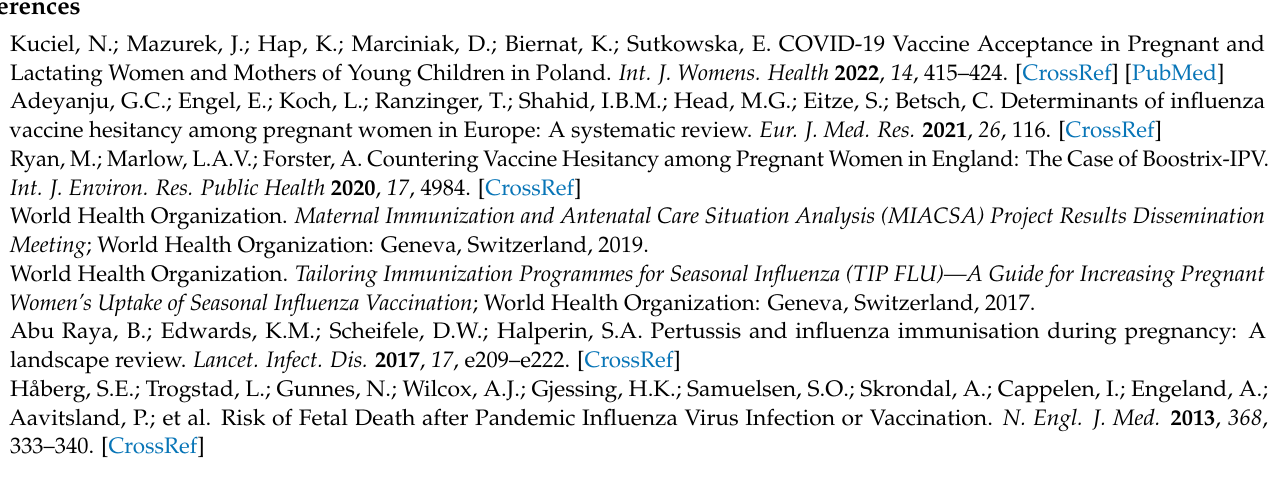
vaccination during pregnancy; Table S2. Factors for decision-making and women’s profiles; Table S3. Motivational factors for deciding to be vaccinated during pregnancy (including original quotes); Table S4. Motivational factors for deciding not to be vaccinated during pregnancy (including original quotes); Table S5. Factors for being vaccinated against pertussis during pregnancy; Table S6. Factors for being vaccinated against influenza during pregnancy; Table S7. Factors for being vaccinated against COVID-19 during pregnancy; Table S8. Recommendations for COVID-19 vaccine during preg- nancy; Table S9. Protocols: perception and monitoring; and Table S10. Reasons for not participating in a clinical